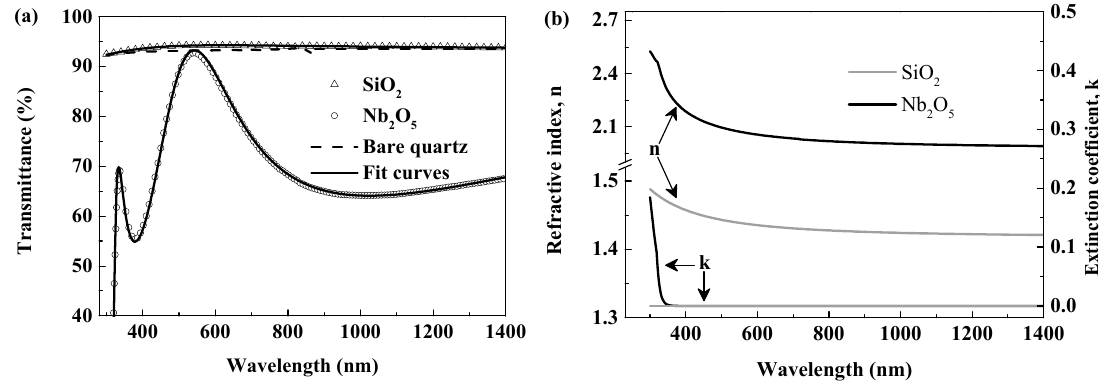
Figure 2. ( a ) Illustration of the experimental (symbols) and calculated (lines) transmittance spectra of film SiO 2 and Nb 2 O 5 ; ( b ) dispersion curves of refractive index and extinction coefficient obtained from transmittance data fits of the corresponding films.